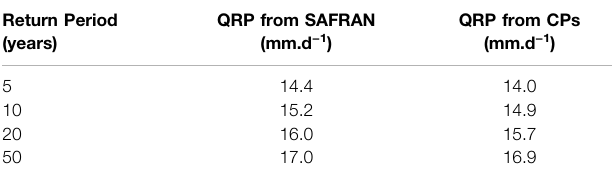
TABLE 5 | Comparison between the discharges from a speci fi c return period (QRP) from the historical reference SAFRAN and those from CPs. The latter were obtained from the equation Q spe (cid:2) f ( RP ) established from the mean of the distribution functions of Q max from the 12 CPs. Return Period QRP from SAFRAN QRP from CPs (years) (mm.d − 1 ) (mm.d − 1